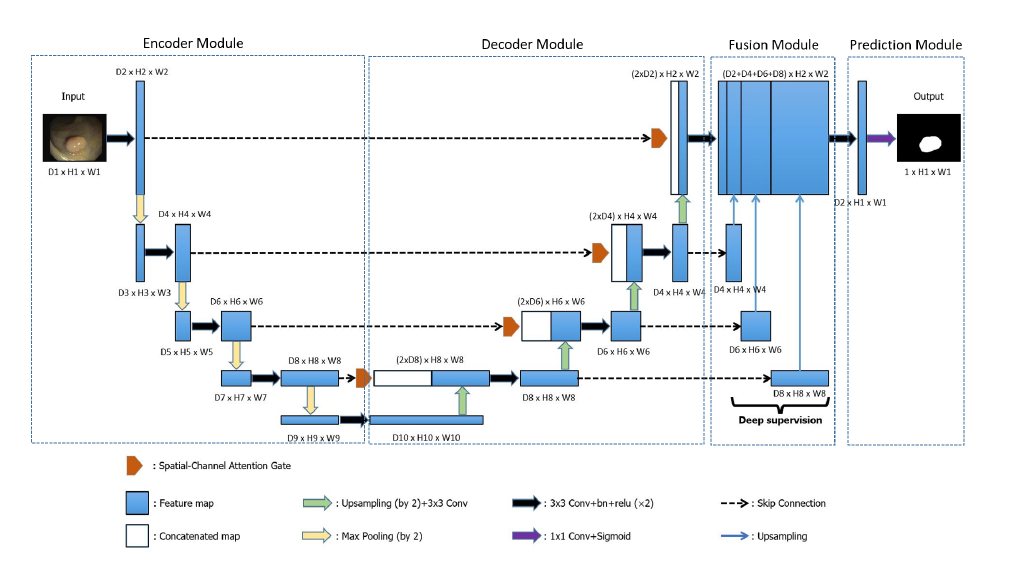
Figure 1. Proposed U-Net model using Spatial-Channel Attention Gate and Deep supervision.